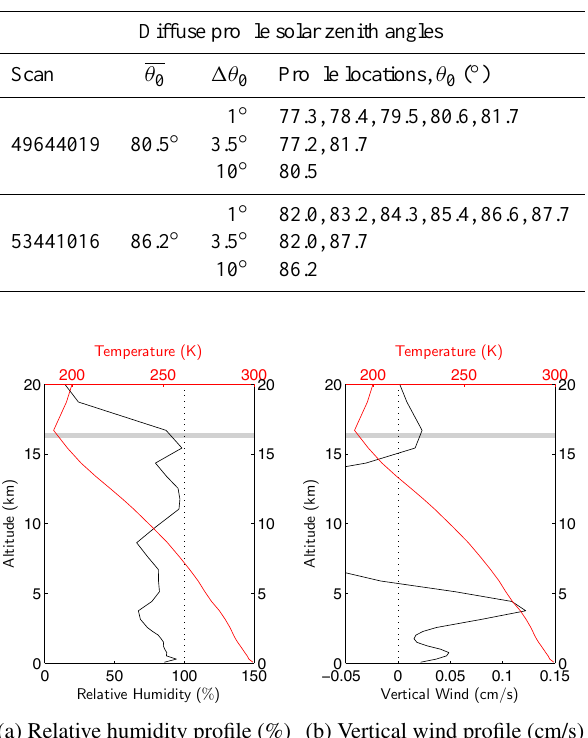
Table 1. Diffuse profile locations for studying the effect of diffuse profile spacing.